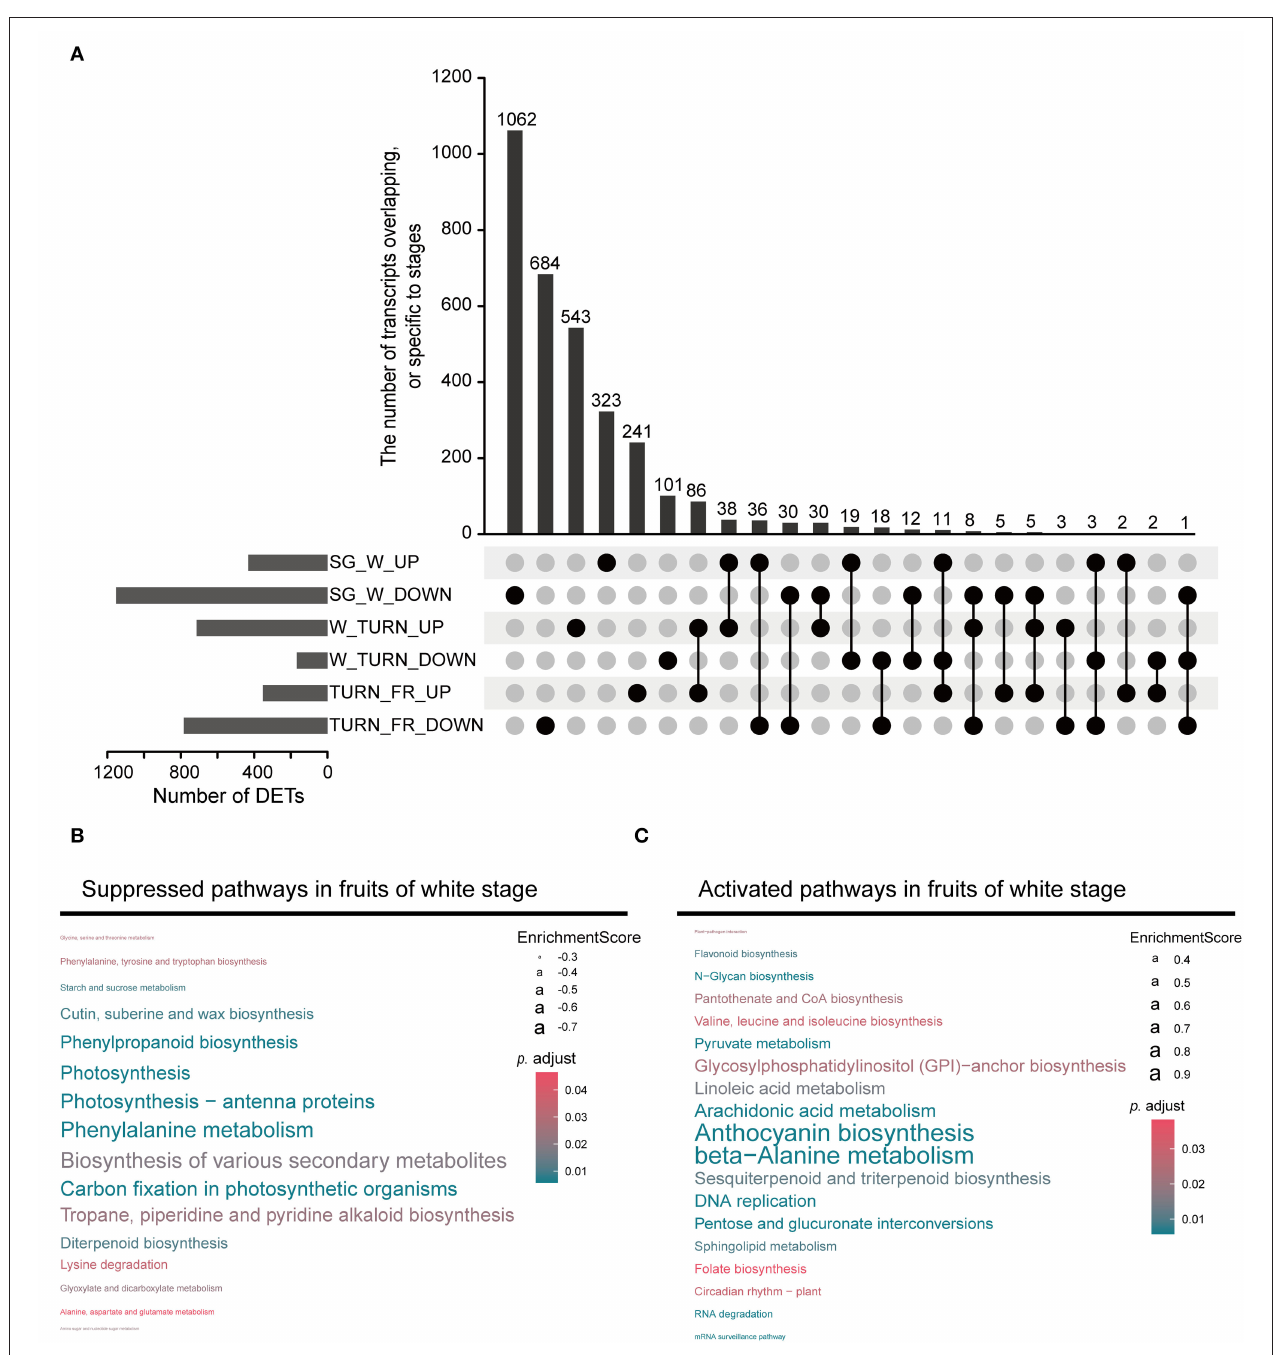
FIGURE 2 | The differentially expressed transcripts (DETs) detected between the two neighboring stages and the enriched gene set. (A) The upset plot representing the DETs in comparison between the small green stage (SG) and the white stage (W), the white stage (W) and the turning stage (TURN), and the turning stage (TURN) and the full red stage fruits (FR). (B) Gene set enrichment analysis (GSEA) revealed the suppressed pathways in the white stage fruits. (C) The activated pathways in fruits of white stage detected by